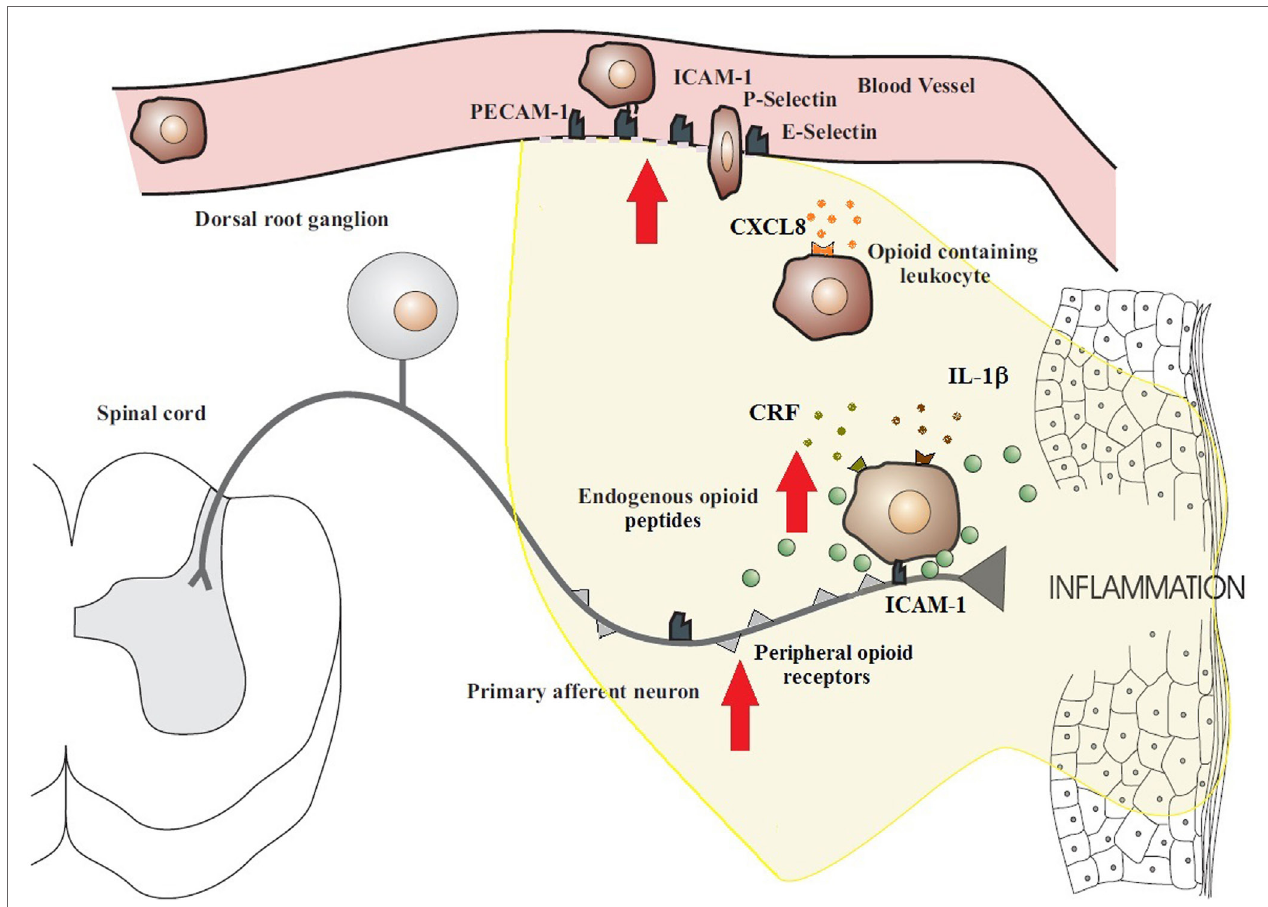
FiGURe 1 | Migration of opioid-containing immune cells and opioid release within inflamed tissue . Adhesion molecules interact with their respective ligands to facilitate endothelial transmigration of immune cells. In response to stress or releasing agents (e.g., CRF, IL-1, and CXCL8), the immune cells secrete opioid peptides. Opioid peptides or exogenous opioids bind to opioid receptors on primary afferent neurons, leading to analgesia. The immune cells, depleted of opioids, then migrate to regional lymph nodes. The arrows denote an increased expression within inflamed tissue of cell adhesion molecules, opioid receptors, endogenous opioid peptides, and receptors for ligands that trigger opioid release on the surface of immune cells (e.g., CXCR2, IL-1 receptors, and CRF receptors). All these enhance the analgesic activity of the peripheral opioid pathway in inflammatory conditions. Figure adapted from Ref. (2).